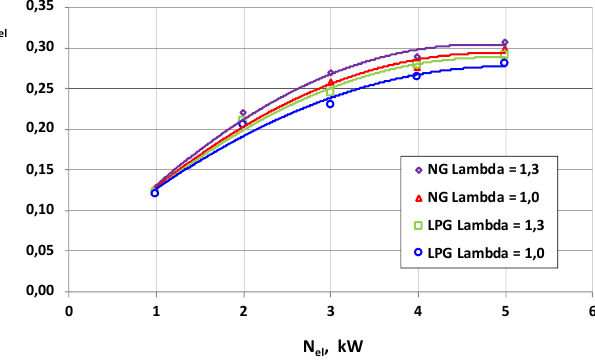
Fig. 9. Electrical efficiency of mCHP unit vs output electric power